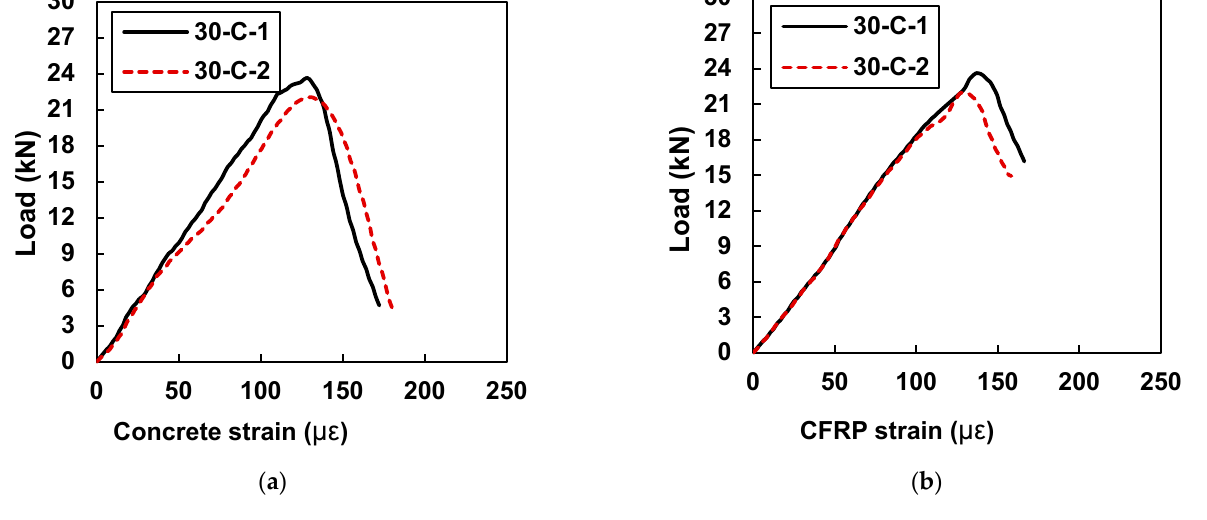
Figure 16. Load vs. strain curves for specimens with 40 mm CFRP strips (40-C-1 and 40-C-2): ( a ) strain in concrete and ( b ) concrete strain in CFRP. Figure 17 exhibits that, in comparison to all tested beam samples, 50-C-1 and 50-C-2 showed the highest values of concrete and CFRP strains. In comparison to the beam samples retrofitted with 40 mm CFRP strips, an average increase of 11% was found in the concrete and CFRP strain values.